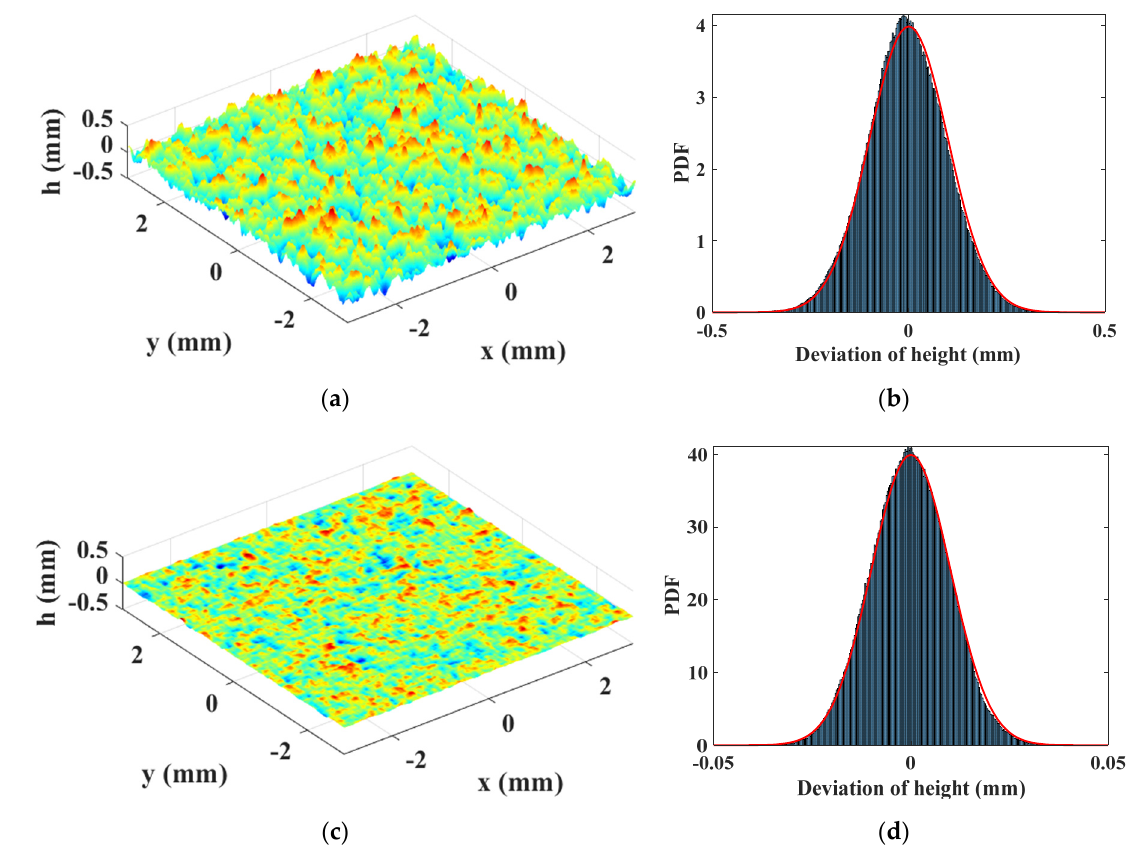
Figure 2. 2D rough surface profiles with different parameters and their height distributions: ( a ) L c = 0.1 mm and R q = 0.1 mm; ( b ) Probability density distribution of ( a ); ( c ) L c = 0.1 mm and R q = 0.01 mm; ( d ) Probability density distribution of ( c